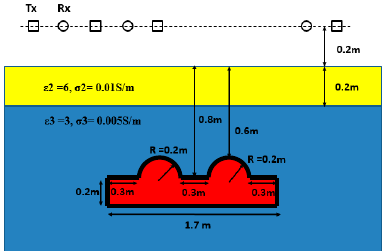
Figure 7. Scene comprising a composite metallic target in a three ‐ layered background environment [4].